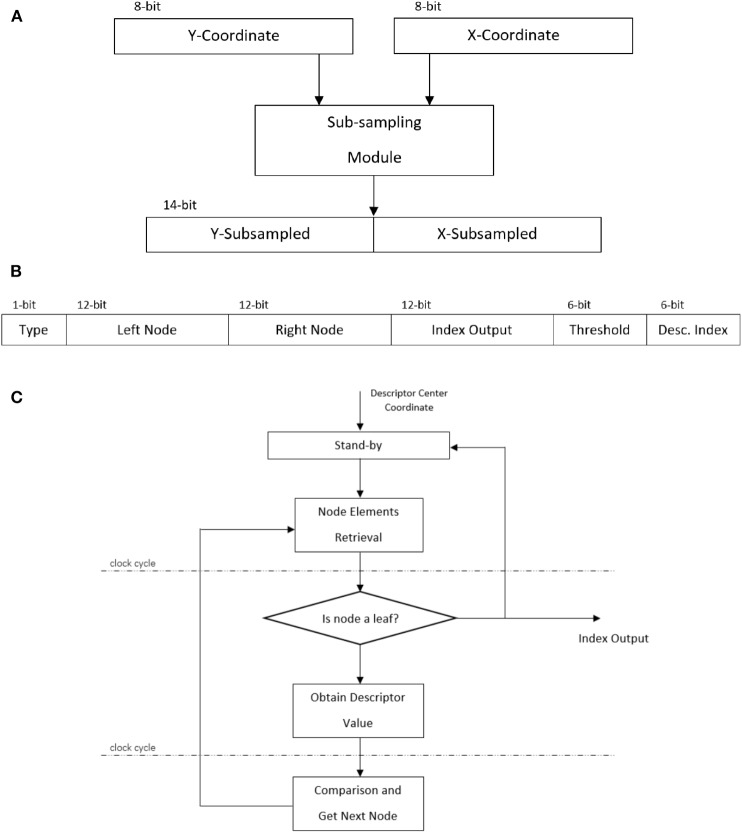
FPGA implementation details: (A) Sub-sampling module, (B) A k-d tree node in hardware, and (C) Recursive logic-driven k-d tree implemented in hardware.